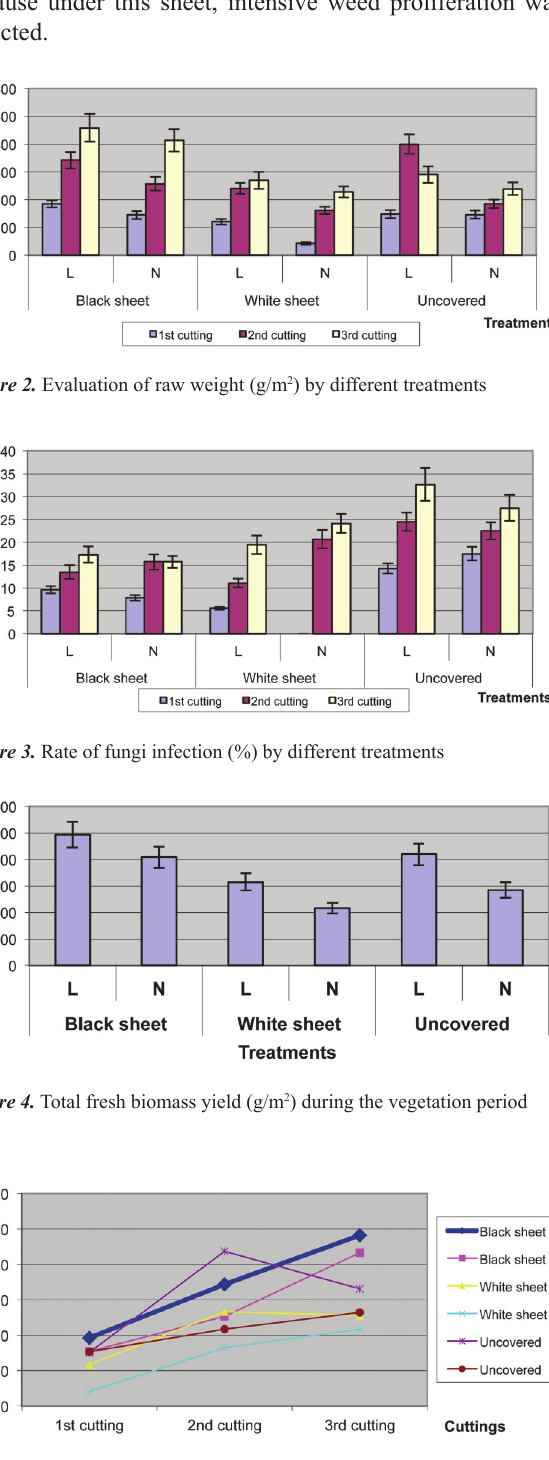
Figure 5. Evaluation of dry weight (g/m 2 ) by different cuttings and treatments